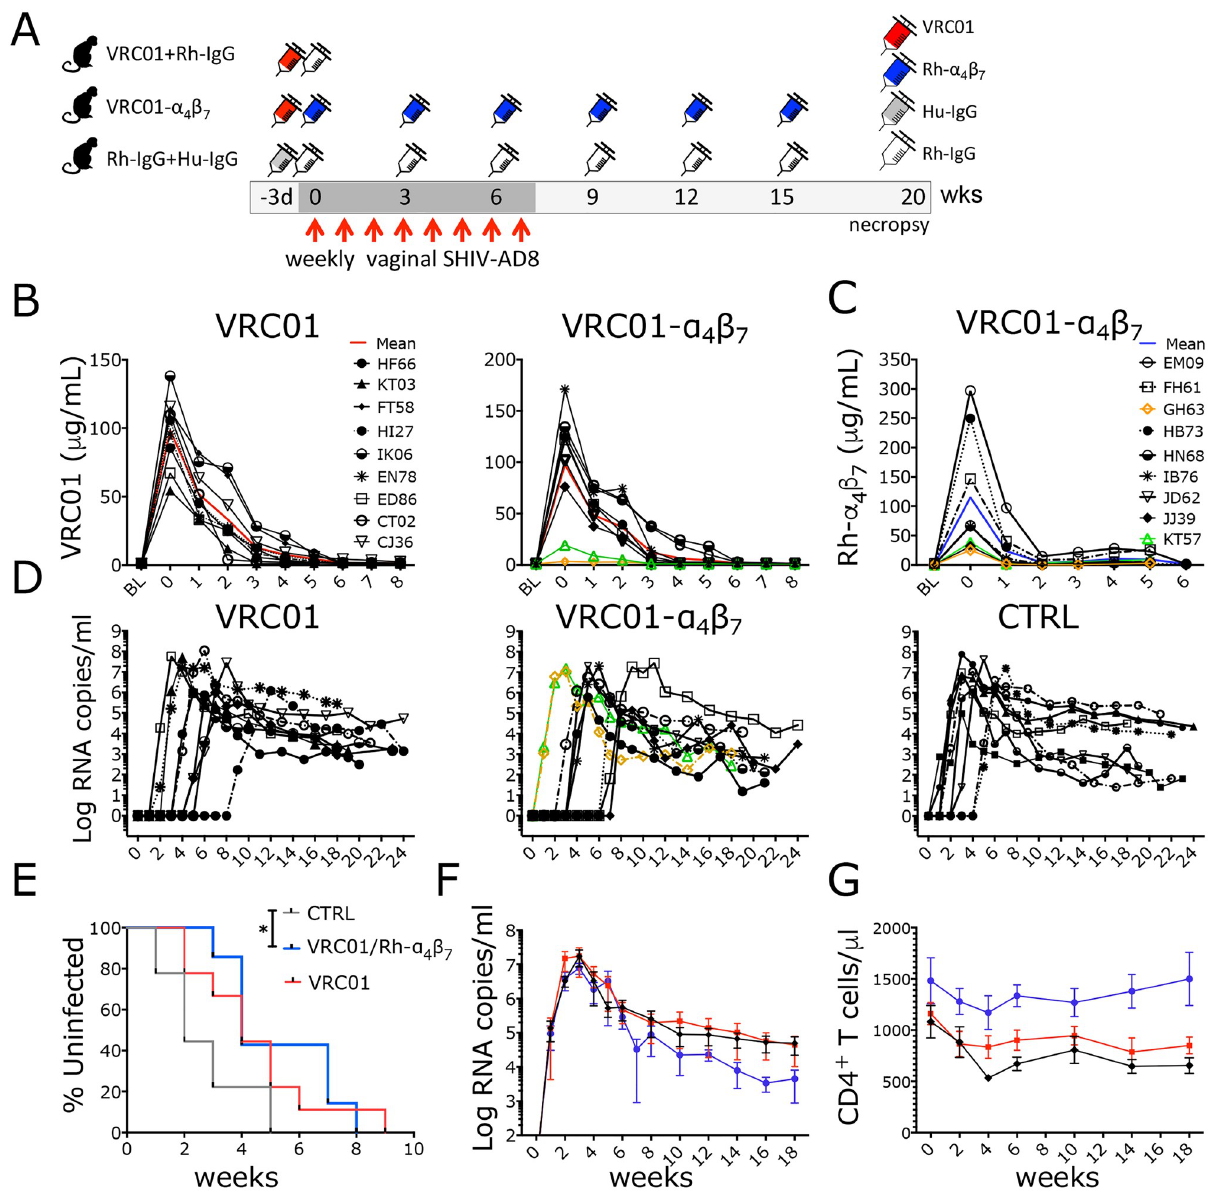
Fig 1. The Rh- α 4 β 7 -VRC01 combination significantly delays SHIV AD8-EO acquisition. (A) Schematic of the study procedures (B-C) The concentrations of VRC01 (B) and Rh- α 4 β 7 (C) were measured in plasma for the first 8 weeks after initiation of treatment. VRC01 levels were below the protective concentration in GH63 and KT57 (orange and green in B, respectively). BL: right before the first infusion with VRC01 and Rh- α 4 β 7 Solid colored line (red for VRC01 and blue for Rh- α 4 β 7 ) represent the mean of all macaques. (D) Log viral RNA (copies/ml) in plasma are shown from the time of the first challenge (week 0). (E) Kaplan-Meier curves generated with time to first viral detection in plasma are shown. Curves were compared with the Log-rank test ( � p -value = 0.016; Gehan-Breslow-Wilcoxon test p = 0.015) α < 0.05 (Bonferroni corrected for multiple comparisons at α < 0.017 was considered significant). (F-G) Mean ± SEM of the plasma viral loads (F) and CD4 + T cell counts (G) are